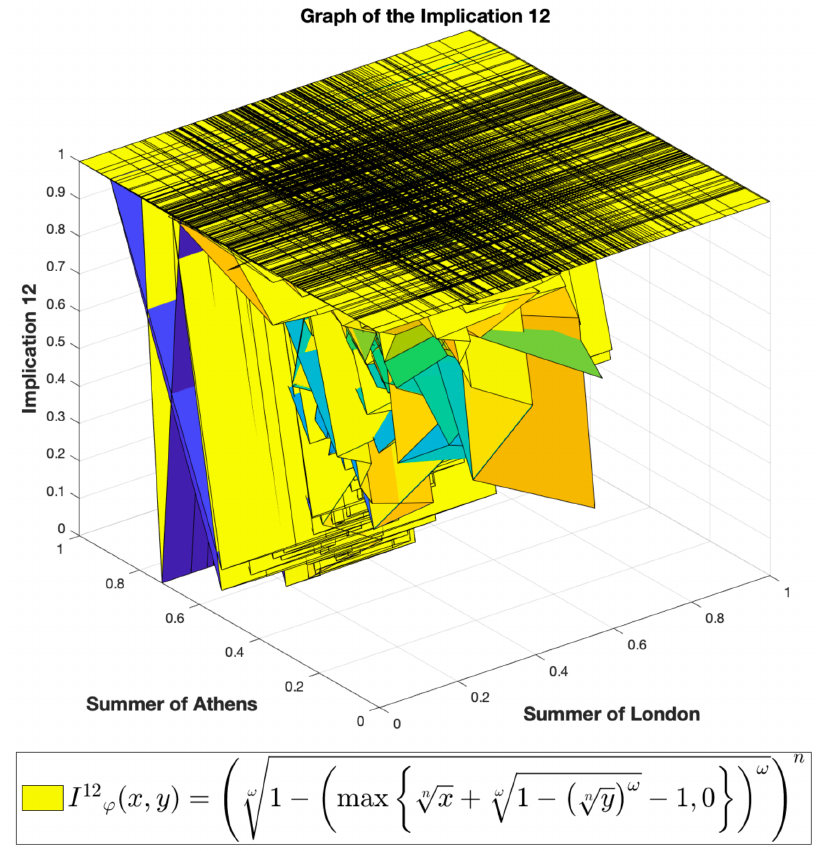
Figure 15. Graph of the Implication